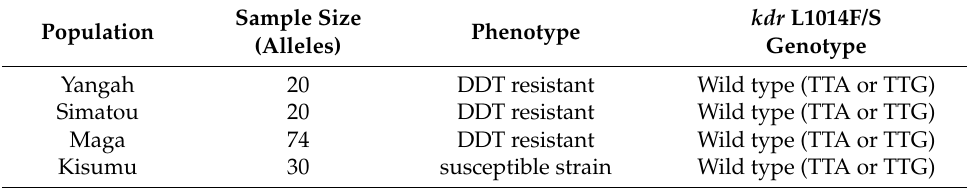
Table 3. Genotyping of An. pharoensis mosquitoes for the L1014F/S mutation.